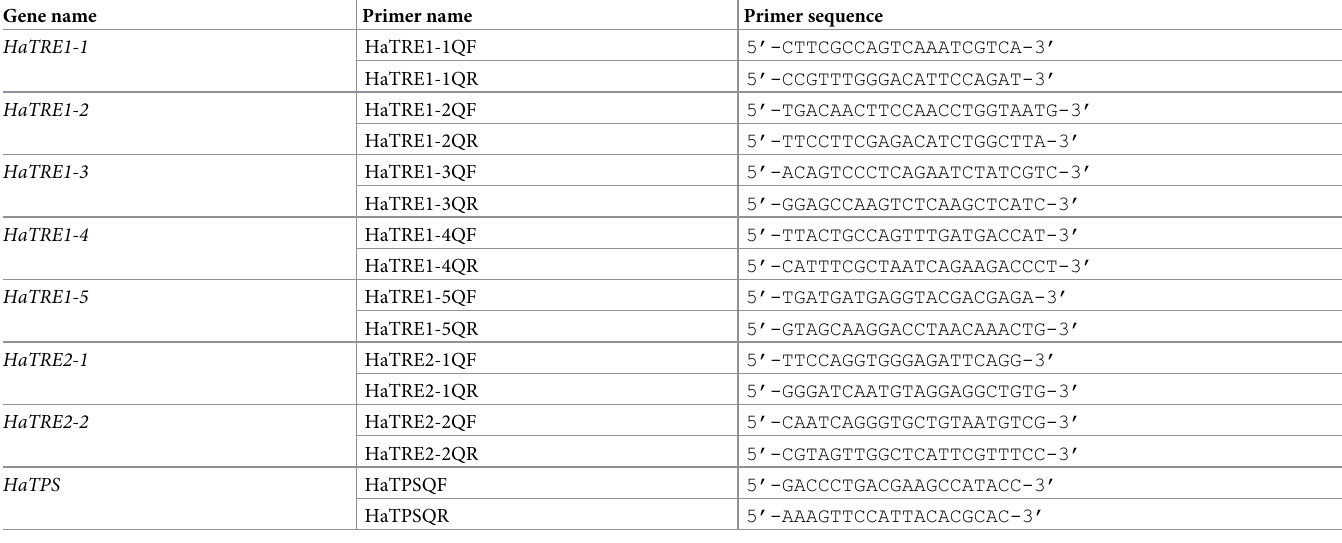
Table 1. Primers for TPS and TRE genes of H . axyridis used in